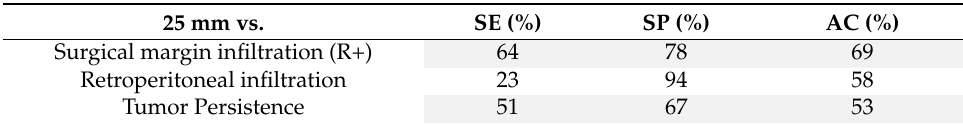
Table 4. Sensitivity, specificity, and accuracy values reported for 25 mm cut-off in reference to the anatomopathological margin infiltration and tumor persistence. AC = Accuracy. SE = Sensitivity. SP = Specificity.